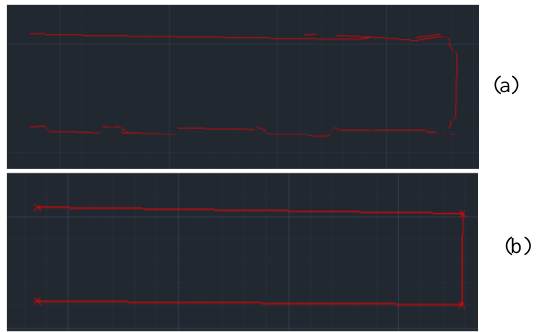
Figure 26. Corridor case: 2D projection lines of the walls (a) before adjustment and connection, (b) after connection, adjustment and edge